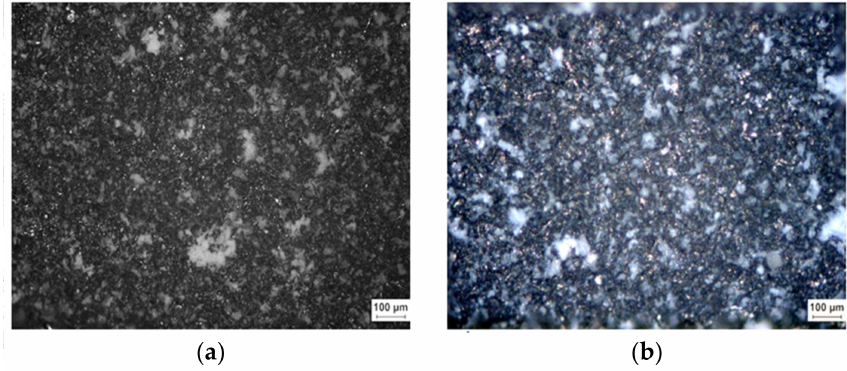
Figure 1. Optical microscopy image of T–ZrO 2 ( A ) and C–ZrO 2 ( B ) particle, used for sundblasting. × 1000.